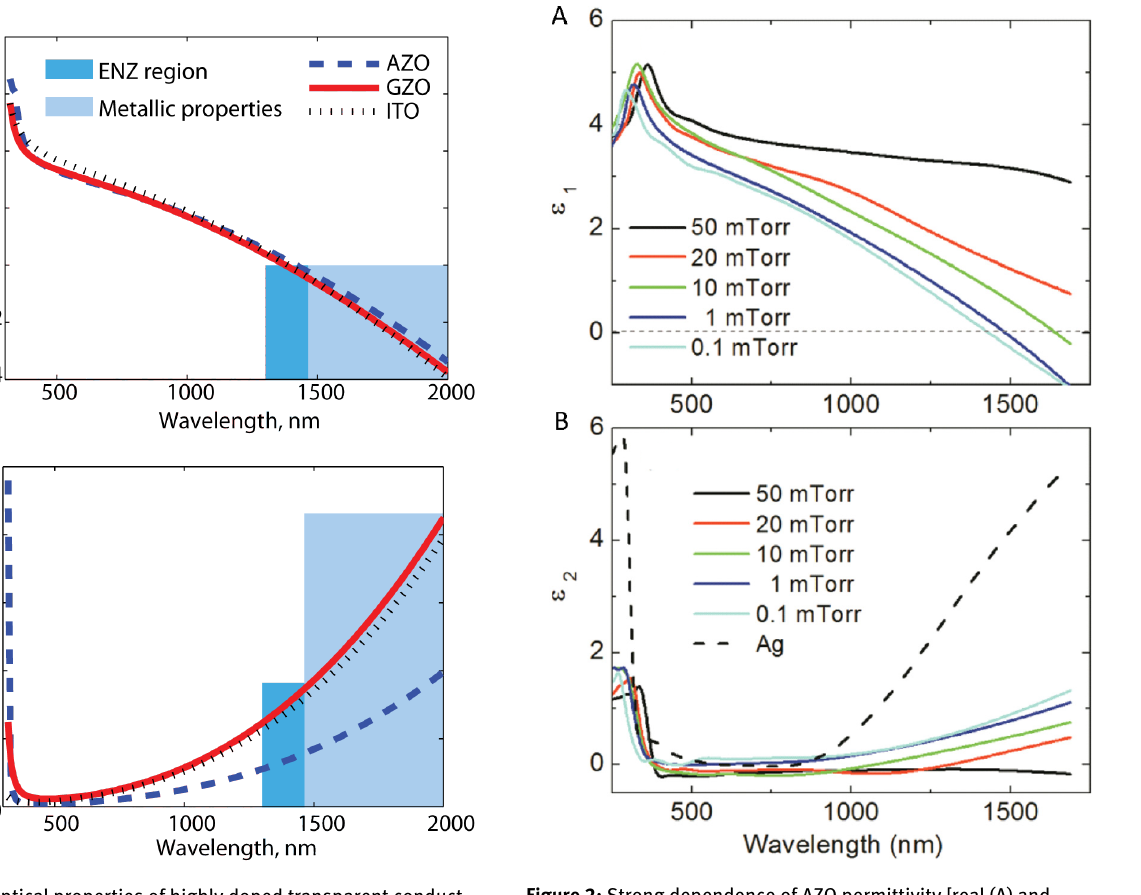
Figure 1: Optical properties of highly doped transparent conduct- ing oxides: (A) real and (B) imaginary parts of permittivity. Shaded parts correspond to wavelengths where TCOs are metallic and al- low plasmonic resonances. Crossover wavelength, that is ENZ re- gion, is approximately at 1400 nm. Real values of permittivities of AZO, GZO, and ITO are similar. However, AZO possesses the lowest losses. The films were deposited using pulsed laser deposition and the deposition conditions were optimized to achieve the highest possible carrier concentration and lowest possible losses. During deposition, the oxygen partial pressure was 0.4 mTorr or lower and the substrate was heated to temperatures around 100°C. The films with thicknesses greater than about 50 nm exhibit very little thickness dependence in their optical properties. For experimental details, see [62] and [65]. Legend is the same on both plots. AZO: